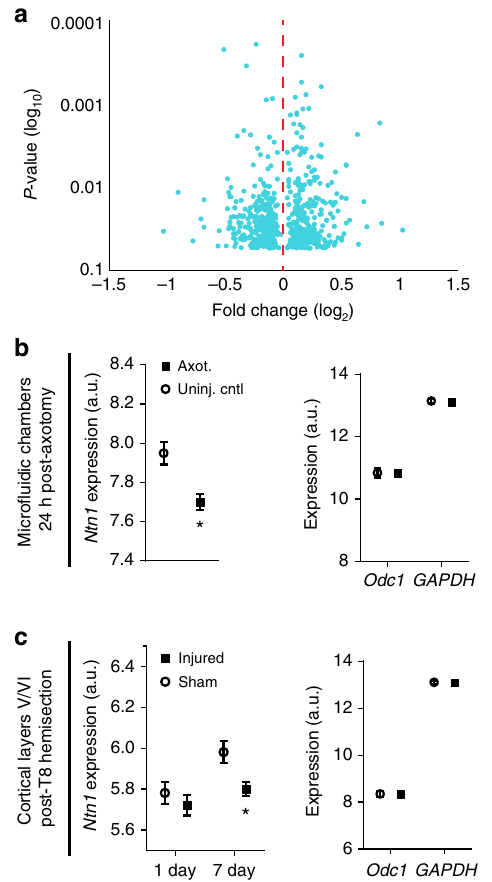
Fig. 7 Netrin-1 gene expression following axotomy in micro fl uidic cultures and in vivo following spinal cord hemi-transection Microarray analysis was performed on somatodendritic samples of uninjured control and 24 h post-axotomy chambers. Quality control data is presented in Supplementary Fig. 5. a Volcano plot showing differentially expressed RNAs that are signi fi cantly changed at 24 h post-axotomy (One-way between- subject ANOVA; n = 3 individual chambers each condition; Supplementary Table 2). b Microarray expression levels for Ntn1 within micro fl uidic chambers ( left ) and for housekeeping genes Odc1 and GAPDH ( right ). One-way between-subject ANOVA. c Microarray expression levels for Ntn1 ( left ) and Odc1 and GAPDH ( right ) in cortical layers V/VI following hemi-transection at thoracic level 8. n = 4 animals per group. Ntn1 levels are signi fi cantly reduced by 7 days following injury. Two-way